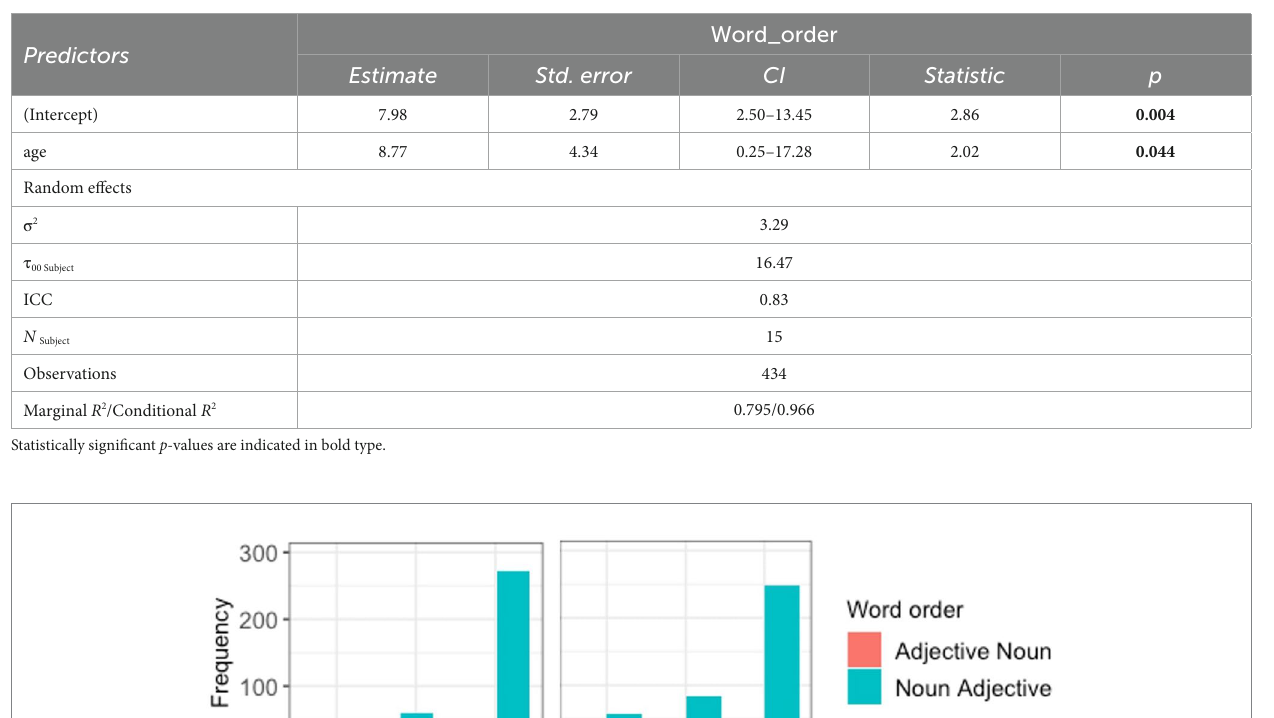
TABLE 8 Output for the final model containing extra-linguistic variables in HL mode with Dutch insertions.